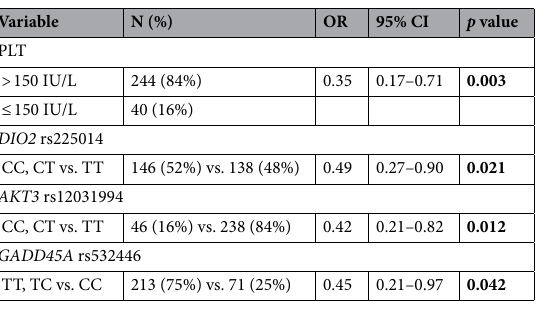
Table 4. Final multiple logistic regression model for ALT levels. Significant values are in bold. CI confidence interval, OR odds ratio; p value.